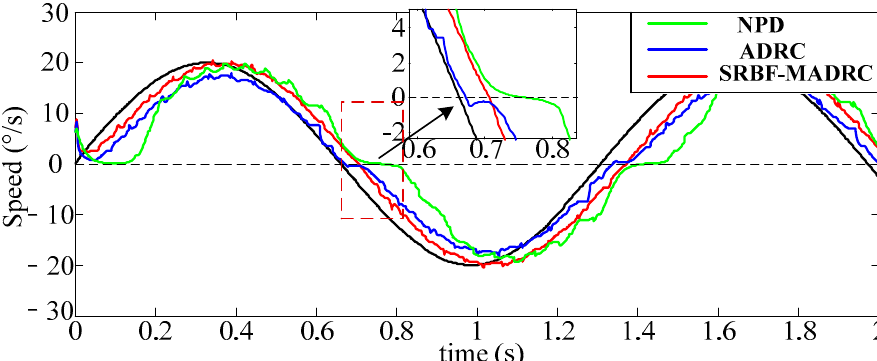
Figure 13. Sinusoidal speed tracking of three algorithms.